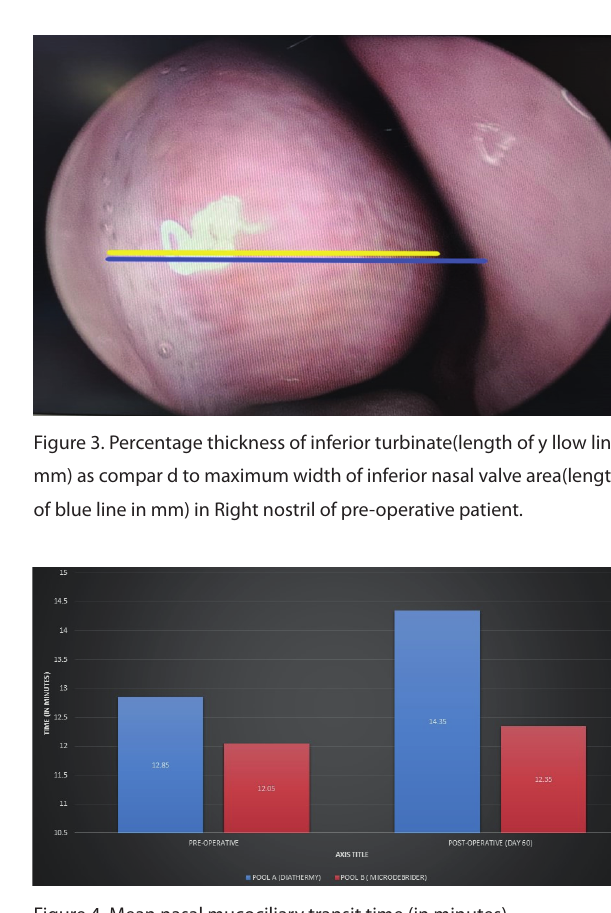
Figure 2. Mean nose core (diathermy vs microdebrider).